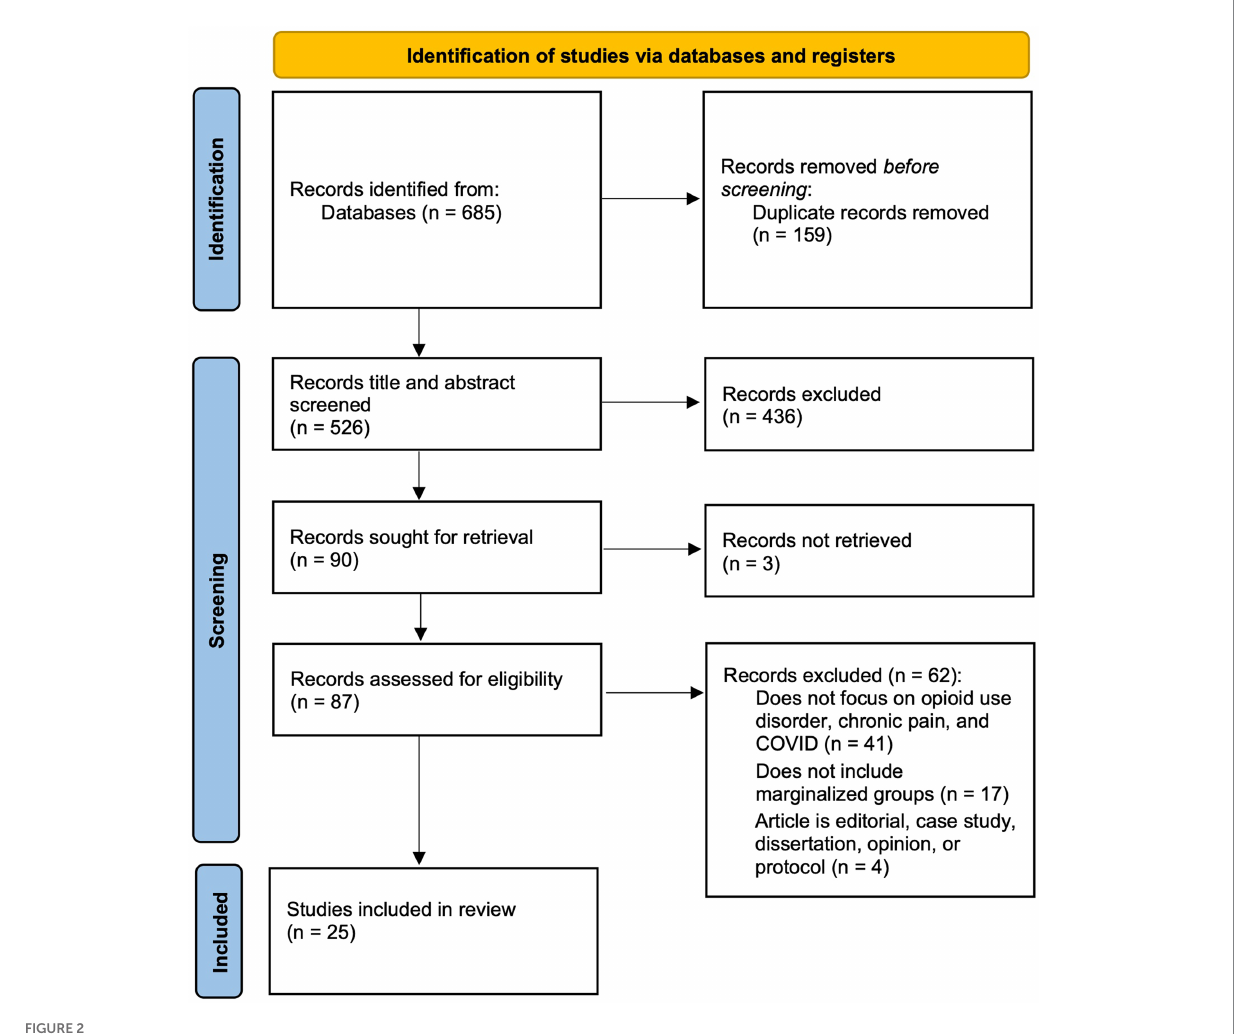
FIGURE 2 PRISMA flow